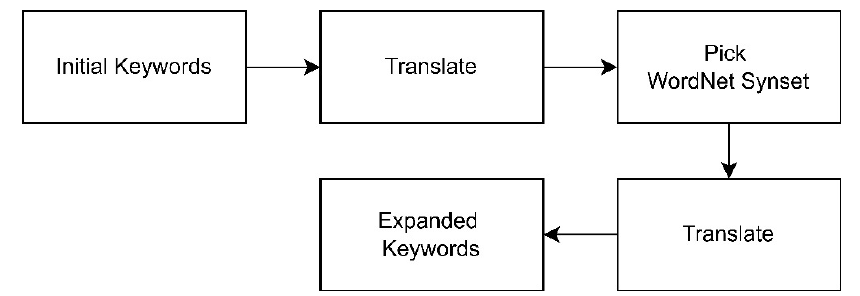
Figure 6. Initial keywords extension.